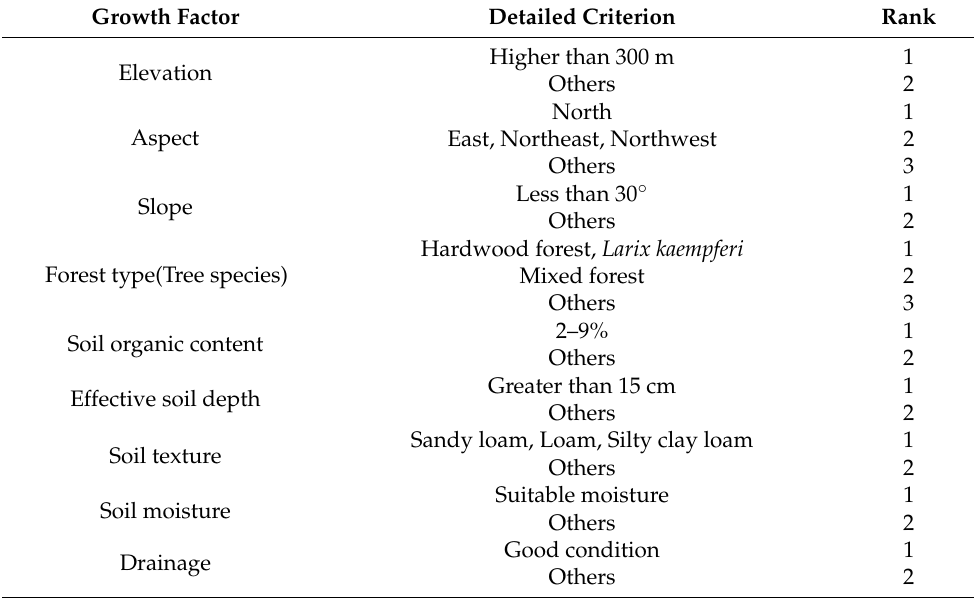
Table 1. Nine growth factors and the detailed criterion of each for identifying the suitable WSG cultivation sites.